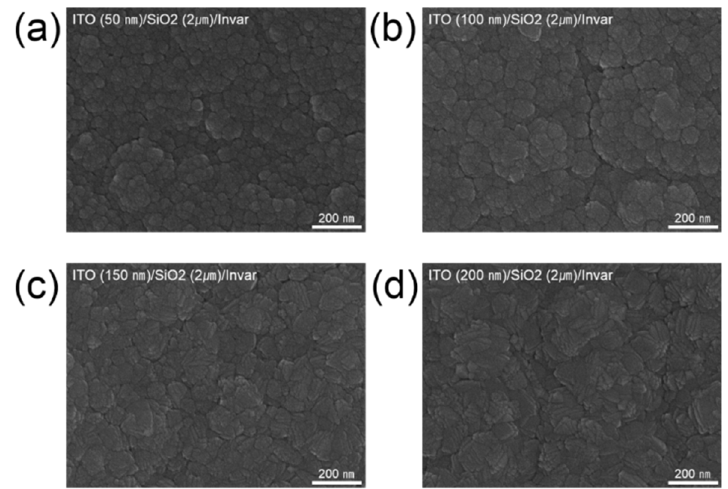
Figure 4. Surface FESEM images of DC sputtered ITO films on SiO 2 /invar substrates; ( a ) 50 nm, ( b ) ( b ) 100 nm, ( c ) 150 nm, and ( d ) 200 100 nm, ( c ) 150 nm, and ( d ) 200 nm.